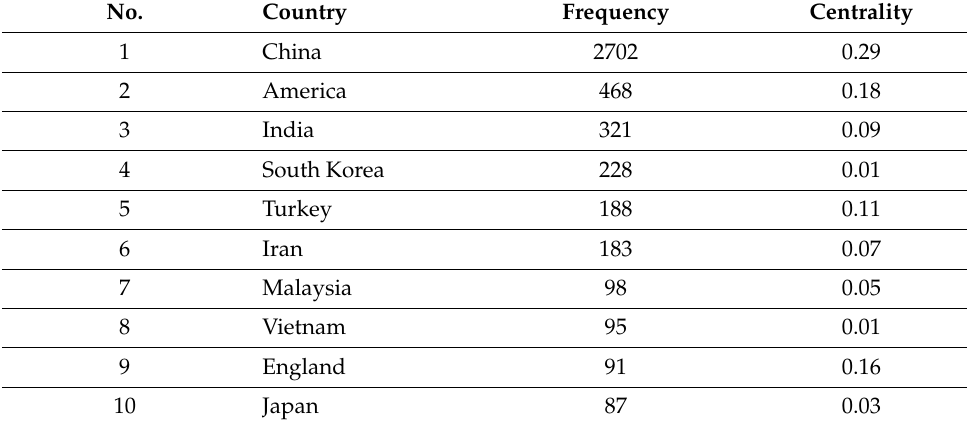
Table 1. High-frequency country in the research area of metamaterial absorber.